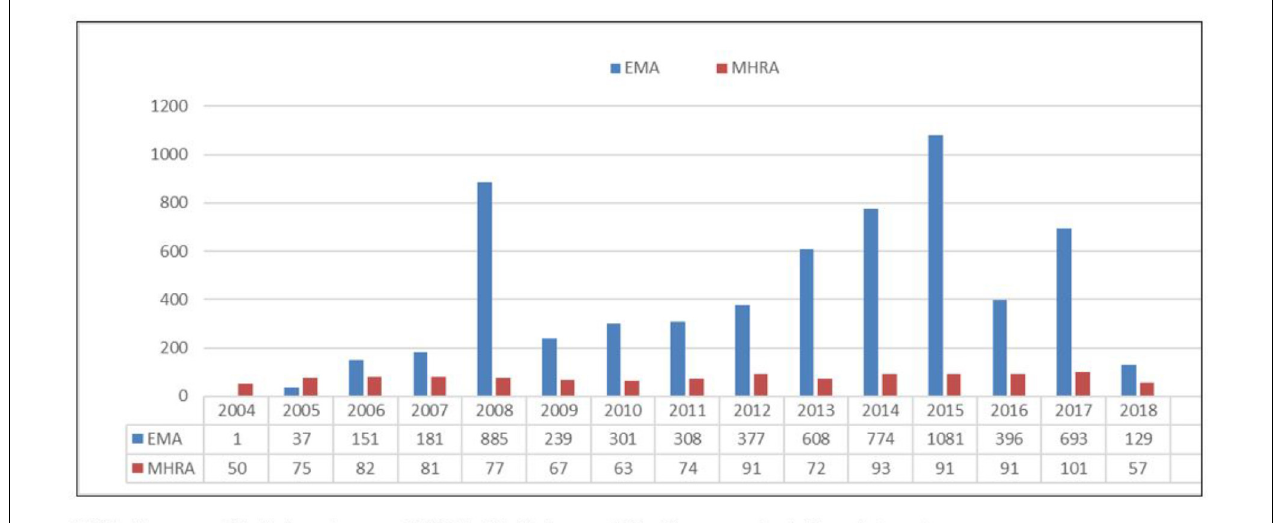
FIGURE 1 | 2004–2018 EMA and MHRA misuse/abuse/dependence/withdrawal-related fentanyl cases. EMA, European Medicines Agency; MHRA, Medicines and Healthcare products Regulatory